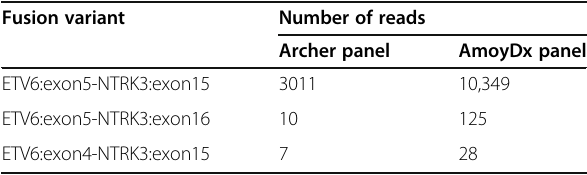
Table 1 Frequency of three different ETV6-NTRK3 fusion variants detected by RNA-Seq Fusion